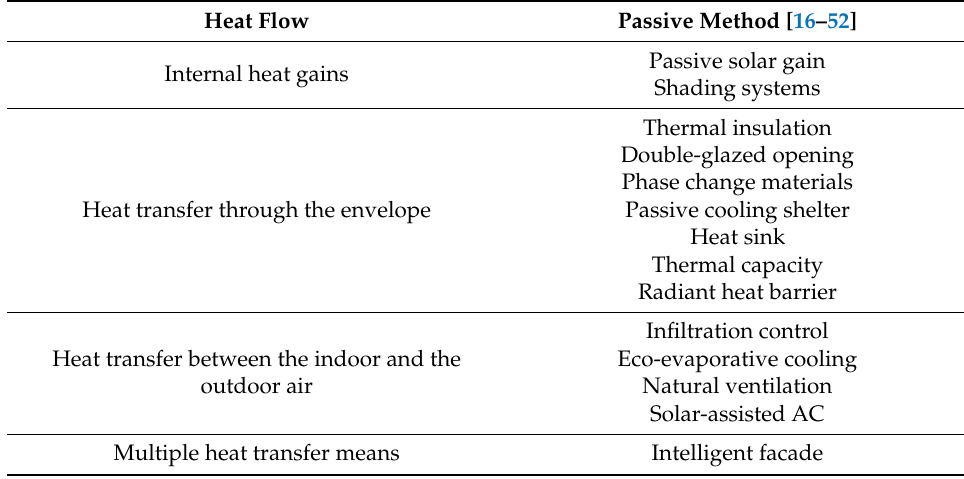
Table 1. Classification of passive methods by heat